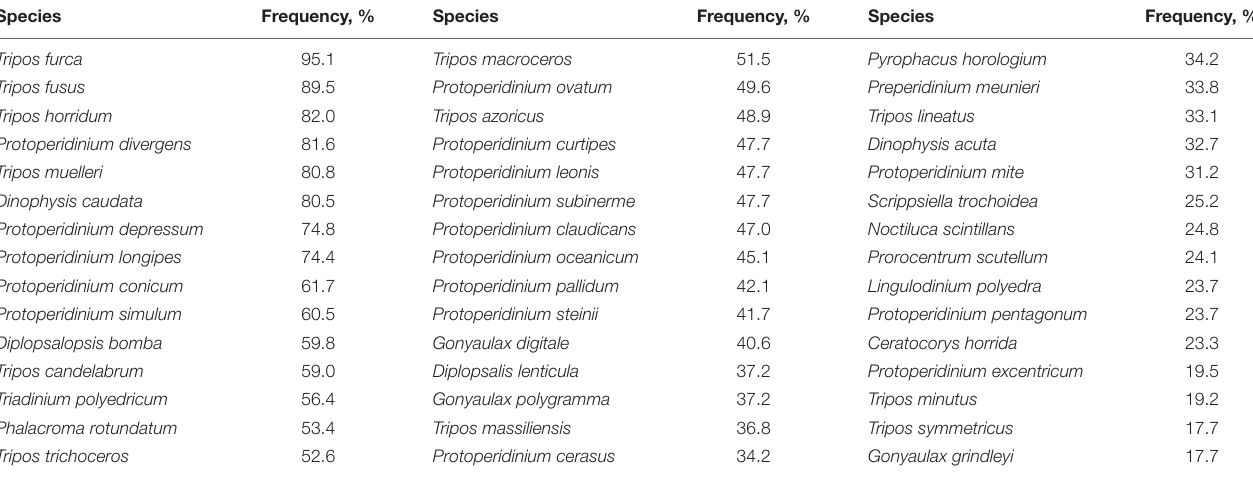
TABLE 1 | Frequencies of occurrence of the most common species of dinoflagellates (samples N = 266; taxa authority listed in Supplementary Appendix 1 ).